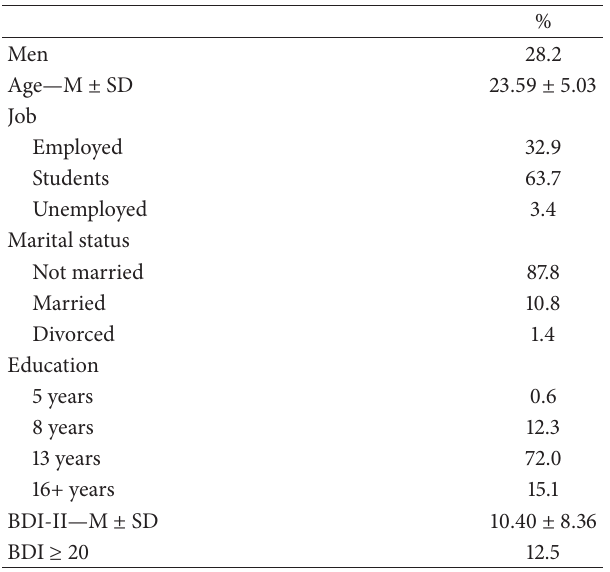
Table 1: Characteristics of the sample. Table2:Factorsolution(PrincipalFactorAnalysis,Promaxrotation with Kaiser